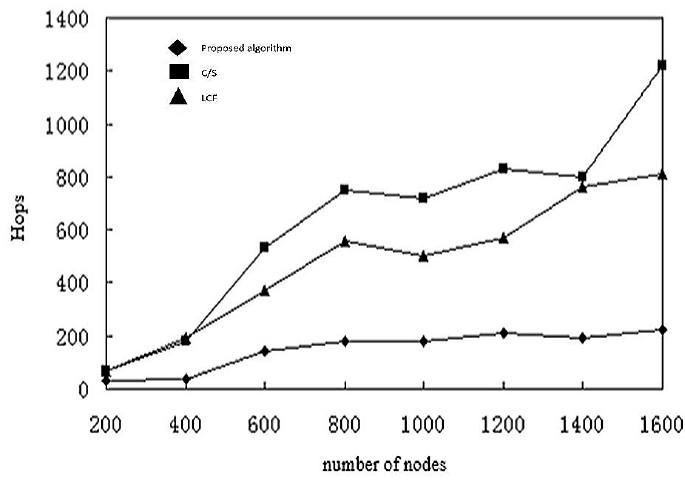
Figure 21. Effect of node density on number of hops.